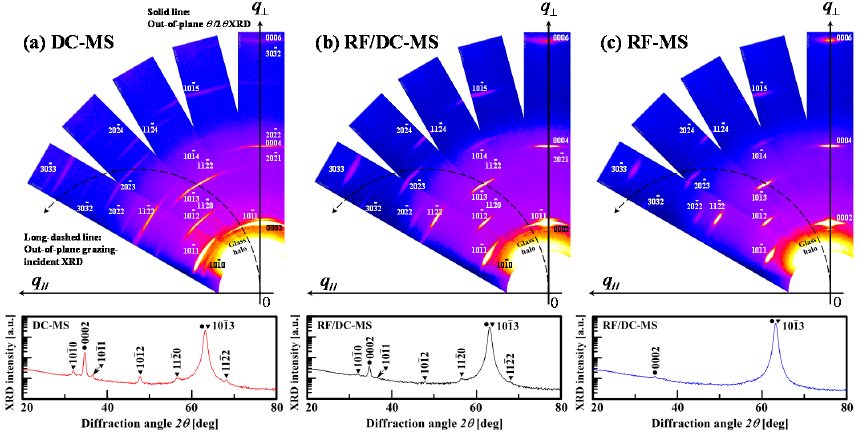
Figure 5. Wide-range XRD reciprocal space maps of 500-nm-thick AZO films deposited by ( a ) DC magnetron sputtering (DC–MS), ( b ) RF/DC magnetron sputtering (RF/DC–MS) at a power ratio of 0.14, and by ( c ) RF magnetron sputtering (RF–MS).